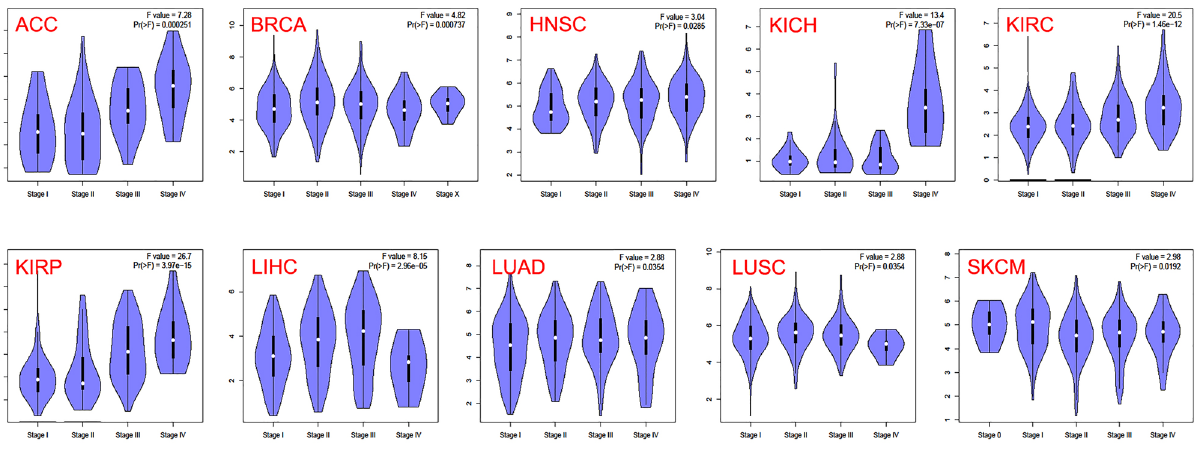
Figure 3. TOP2A expression of various pathological stages in various corelated with poor prognosis (Fig. 5L). MicroRNA-139-5p had a tendency but not reached statistical signifi- cance ( p = 0.091, Fig. 5L). Predictive analysis of upstream lncRNAs of TOP2A‑bound miRNAs. The starBase database was used to predict upstream lncRNAs of the above-mentioned miRNAs with expression and survival significance in KIRC, KIRP, LIHC and LUAD. According to ceRNA mechanism, the upstream lncRNAs should be negatively correlated with target miRNAs. Moreover, the expression of lncRNAs should be higher than normal tissues. In KIRC, Small Nucleolar RNA Host Gene 3 (SNHG3) was significantly negatively correlated with miR-139-5p (R = − 0.24, p < 0.001), and it was positively correlated with TOP2A (R = 0.19, p < 0.001, Fig. 6A). Besides, the expression of SNHG3 was higher in KIRC tissues than normal tissues ( p < 0.001, Fig. 6B). In addition, the prog- nosis of KIRC patients with high SNHG3 expression showed poor prognosis ( p < 0.001, Fig. 6C). In KIRP, TMEM147 Antisense RNA 1 (TMEM147-AS1, R = − 0.44), N4BPL2 Intronic Transcript 2 (N4BP2L2- IT2, R = − 0.39), THUMPD3 Antisense RNA 1 (THUMPD3-AS1, R = − 0.35), E2F1-Regulated Inhibitor of Cell Death (ERICD, R = − 0.34), TTN Antisense RNA 1 (TTN-AS1, R = − 0.33), SH3BP5 Antisense RNA 1 (SH3BP5- AS1, R = − 0.26), THRB Intronic Transcript 1 (THRB-IT1, R = − 0.21), Small Nucleolar RNA Host Gene 3 (SNHG3, R = − 0.20) and Nuclear Paraspeckle Assembly Transcript 1 (NEAT1, R = − 0.20) were negatively cor- related with miR-139-5p (all p values < 0.001), and all of them were higher in KIRP tissues compared to normal tissues (all p values < 0.05, Table 2). The expression of ERICD (R = 0.20), SNHG3 (R = 0.16) and N4BP2L2-IT2 (R = 0.13) was positively correlated with TOP2A (all p values < 0.05, Table 2). Furthermore, as showed in Fig. 6D, increased expression of THUMPD3-AS1 ( p = 0.043), ERICD ( p = 0.015) and SNHG3 ( p = 0.001) was significantly related to a poor OS. As for miR-362-3p, there was no lncRNA significantly negatively correlated with it in KIRP (R < − 0.20). In LIHC, SNHG3 (R = − 0.43), THUMPD3-AS1 (R = − 0.38), NUTM2B Antisense RNA 1 (NUTM2B-AS1, R = − 0.29) and NUTM2A Antisense RNA 1 (NUTM2A-AS1, R = − 0.25) were significantly negatively correlated with miR-139-5p (all p values < 0.001), and all of them were higher in LIHC tissues compared to normal tissues (all p values < 0.001, Table 3). All of the above lncRNAs were positively correlated with TOP2A in LIHC (all p values < 0.001, Table 3). As showed in Fig. 6E, increased expression of SNHG3 ( p < 0.001), THUMPD3-AS1 ( p < 0.001), NUTM2B-AS1 ( p = 0.011) and NUTM2A-AS1 ( p = 0.009) in LIHC was significantly related to a poor OS. As for miR-101-3p, Small Nucleolar RNA Host Gene 6 (SNHG6, R = − 0.38), G-Quadruplex Forming Sequence Containing LncRNA (GSEC, R = − 0.38), Small Nucleolar RNA Host Gene 1 (SNHG1, R = − 0.35), Small Nucleolar RNA Host Gene 14 (SNHG14, R = − 0.27), Long Intergenic Non-Protein Coding RNA 265 (LINC00265, R = − 0.27) and MIR3142 Host Gene (MIR3142HG, R = − 0.25) were significantly negatively cor- related with it (all p values < 0.001), and all of them were higher in LIHC tissues compared with normal tissues (all p values < 0.01, Table 3). Besides, the above miR-101-3p-bound LncRNAs were positively correlated with TOP2A (all p values < 0.001, Table 3). Moreover, high-expression groups of these 6 lncRNAs showed worse OS in LIHC compared to the low-expression gourps (Fig. 6F). In LUAD, TYMS Opposite Strand RNA (TYMSOS, R = − 0.29), HELLP Associated Long Non-Coding RNA (HELLPAR, R = − 0.26), SNHG1 (R = − 0.23), GSEC (R = − 0.22) and SNHG6 (R = − 0.21) were significantly negatively correlated with miR-101-3p (all p values < 0.001), and all of them were higher in LUAD tissues com- pared with normal tissues (all p values < 0.001, Table 4). In addition, these lncRNAs were positively correlated with TOP2A in LUAD (all p values < 0.001, Table 4). Furthermore, increased expression of TYMSOS ( p = 0.003) and GSEC ( p < 0.001) was significantly related to poor OS, and SNHG6 nearly reached statistically significant ( p = 0.055, Fig. 6G). As for miR-139-5p and miR-26a-5p, there was no lncRNA significantly negatively correlated with it in LUAD (R < − 0.20). Taken together, we summarized the predictive ceRNA networks of TOP2A in KIRC, KIRP, LIHC and LUAD in Fig. 7.